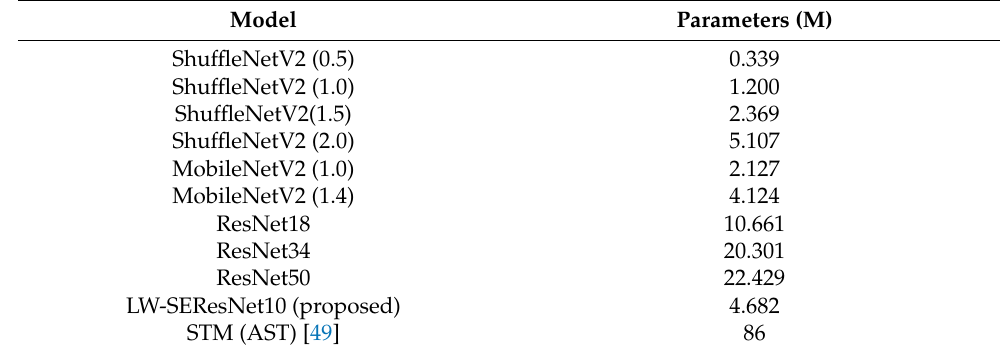
Table 7. The number of parameters of multiple models.